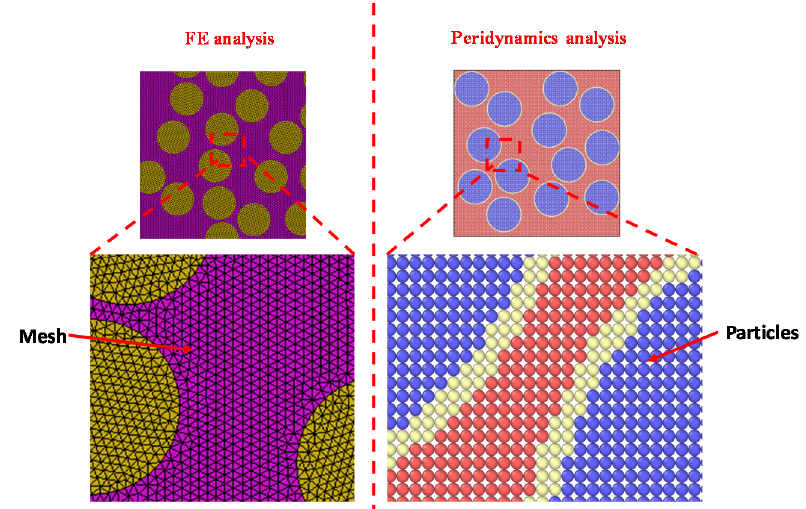
Figure 3. Sample mortar unit cell to describe the mesh-free approach in peridynamics as contrasted with the finite element (FE) mesh.